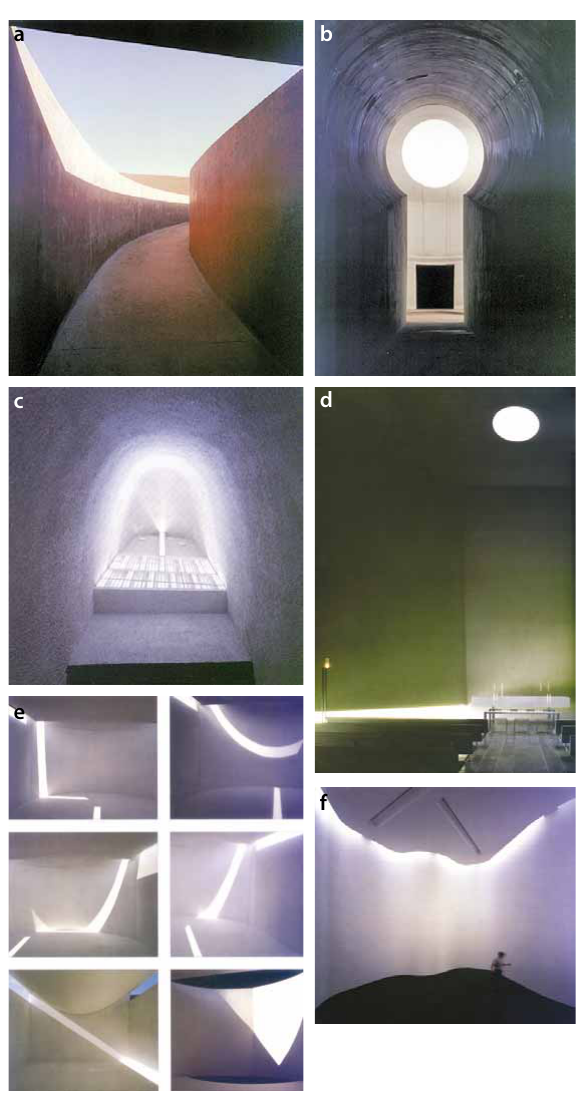
Fig. 5. Koshino House (a), Japan. Archit. T.